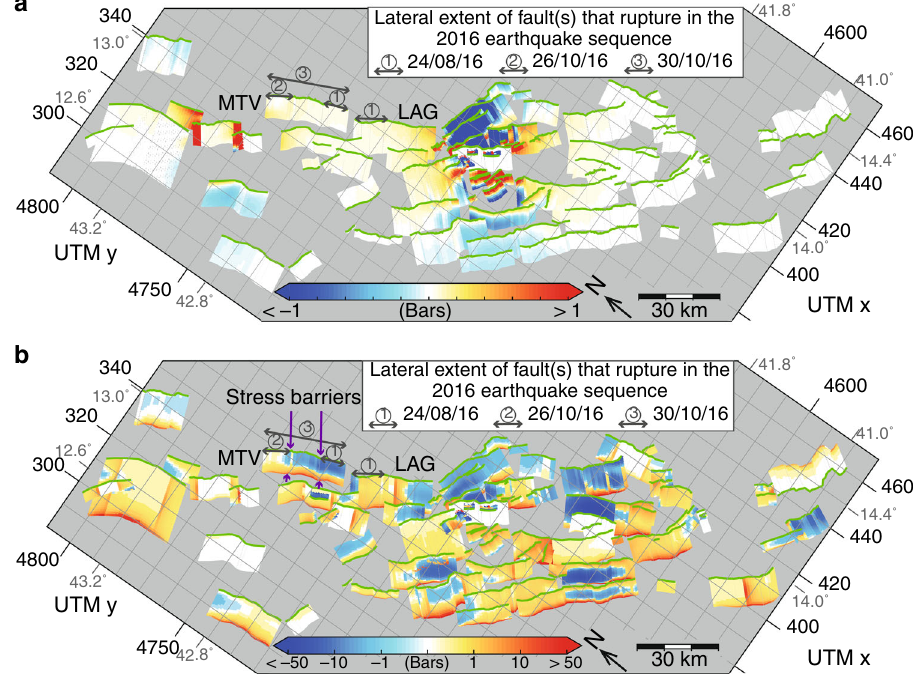
Fig. 3 Short-term and long-term Coulomb stress models prior to 2016. a Coseismic CST from 1997 – 2009 from four earthquakes ( M w = 5.7, 6.0, 5.6, and 6.3) summed together. The faults that ruptured in the sequence are labeled (MTV- Mt. Vettore, LAG- Laga) and the extent of the faults that ruptured in the three events (1. 24 August 2016, 2. 26 October 2016, 3. 30 October 2016) is shown. b Map of cumulative interseismic and coseismic CST from 1349 A.D. to early 2016 A.D. showing the Coulomb pre-stress prior to the 2016 – 17 seismic sequence. Note the non-linear colour scale of cumulative CST. The faults that ruptured in the sequence are labeled as in a . Purple arrows show the location of inferred negative stress barriers 37 . See Supplementary Data 1 and Supplementary Movie 1 for coseismic CST associated with historical earthquakes ( M w > 5.5) since 1349 A.D. See Supplementary Data 2 and Supplementary Movie 2 for the Coulomb pre-stress on each fault prior to each historical